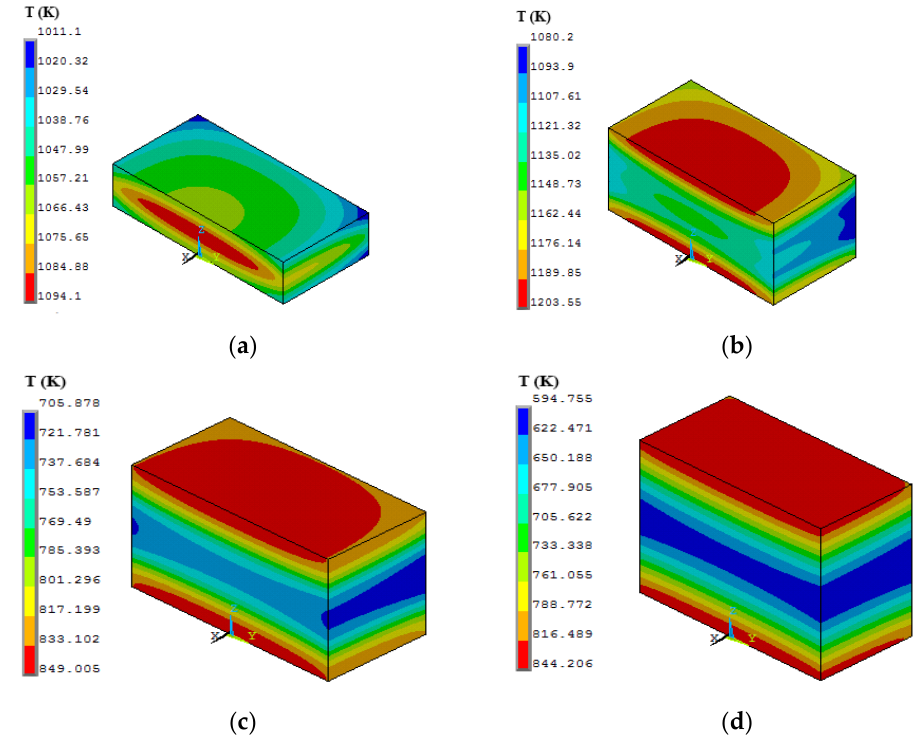
Figure 5. Temperature distribution inside the ilmenite slab after being heated for 4 min with the variation of slab height: ( a ) b = 0.015 m; ( b ) b = 0.03 m; ( c ) b = 0.045 m; ( d ) b = 0.06